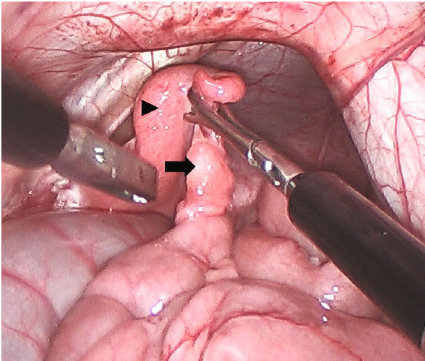
Figure 1: After insu ffl ation, the uterine body was identi fi ed with the help of traumatic and Babcock laparoscopic forceps. The right uterine horn (black arrowhead) was grasped with Babcock forceps. The right ovary is visible (indicated with the black arrow). Ovaries were approximately 8mm in